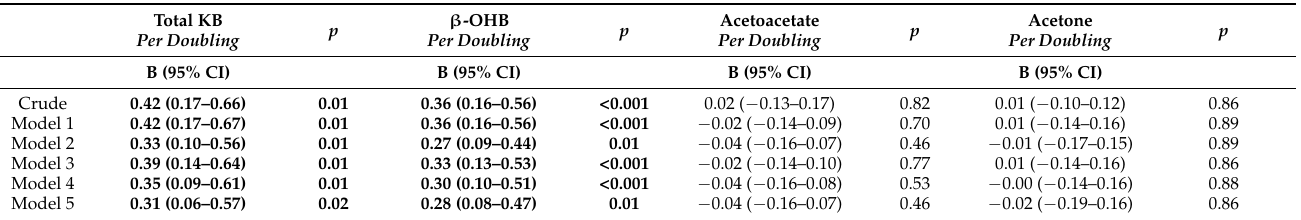
Table 2. Cross-sectional associations between fasting plasma KB and baseline HbA1c levels in linear regression analyses in ZODIAC.